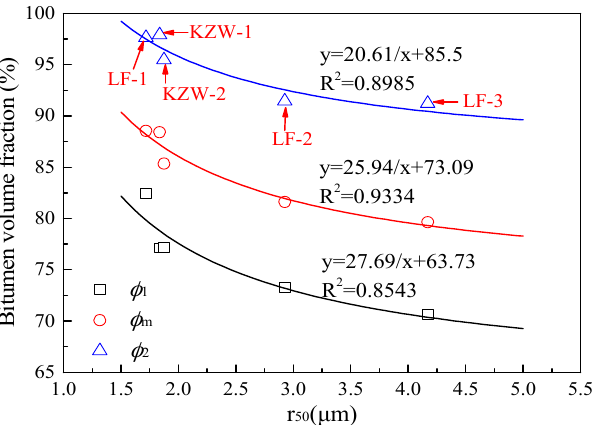
Figure 10. Relation of drying parameters ( ϕ 1 , ϕ m and ϕ 2 ) with r 50 for the five emulsions.